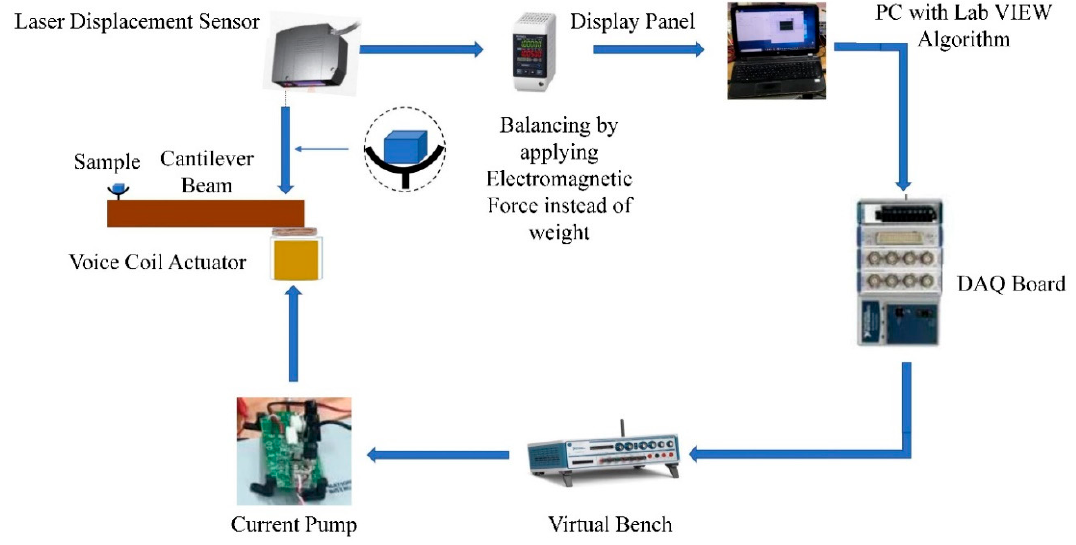
Figure 2. Experimental setup of force balance compensation-type scale.